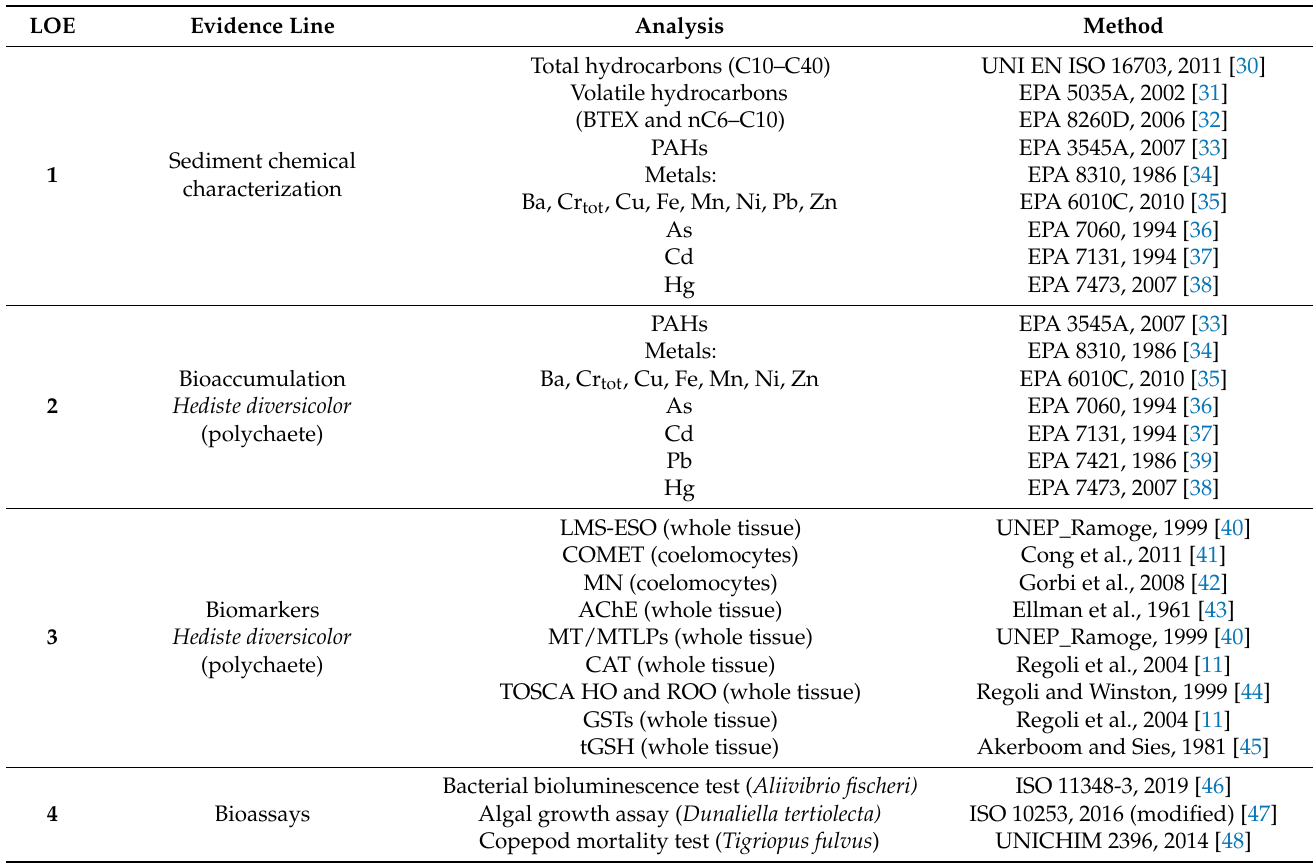
Table 1. The analyzed parameters and adopted protocols for each Line of Evidence (LOE).